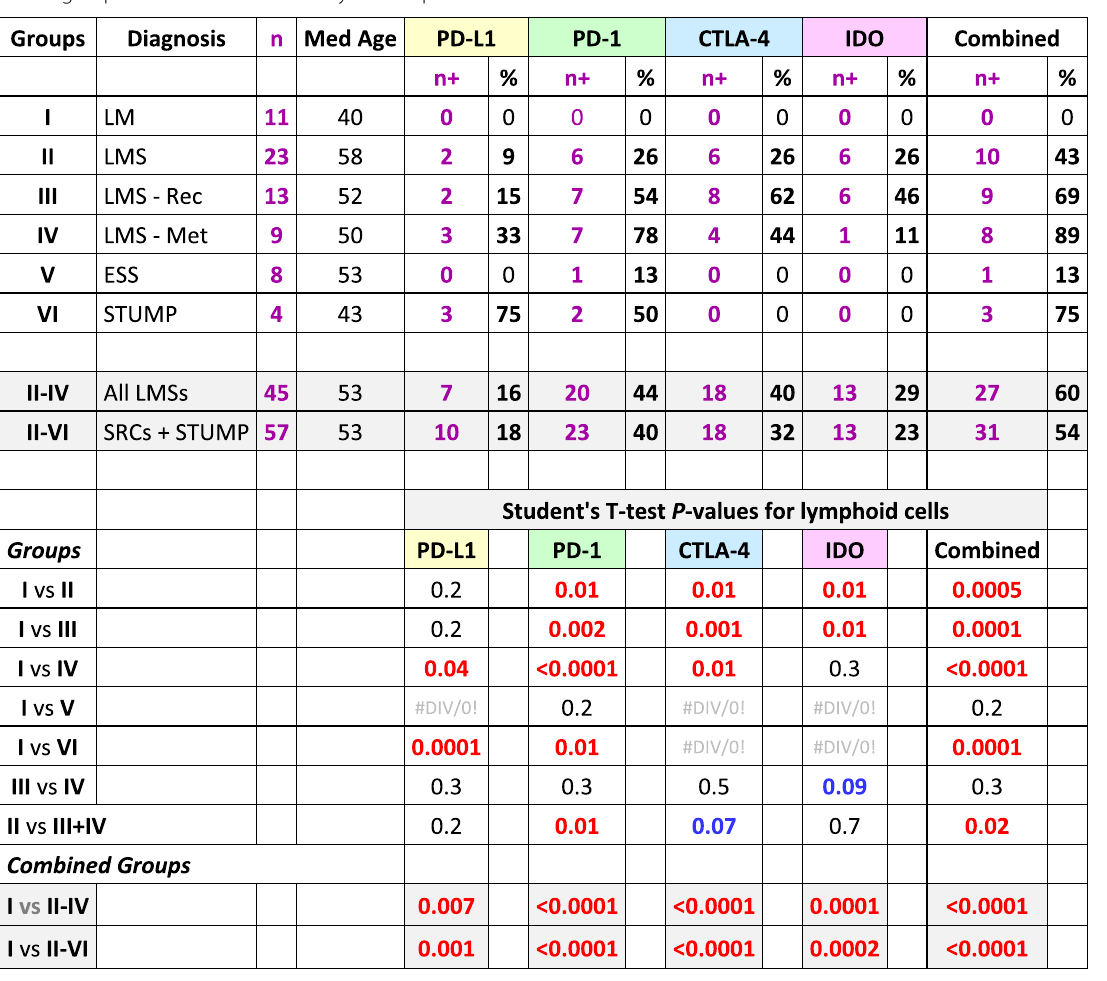
Table 2 Summary of the immunohistochemical reactions of the immune checkpoints results on the tumor lymphoid cells infiltrate in the six groups of the uterine mesenchymal